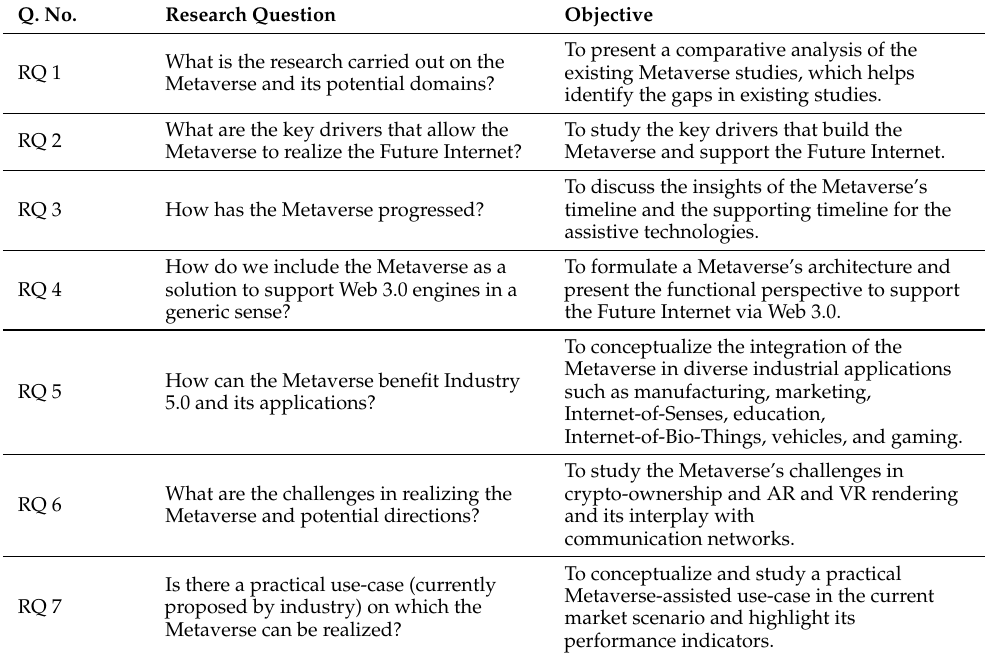
Table 3. Research questions to be addressed in the proposed